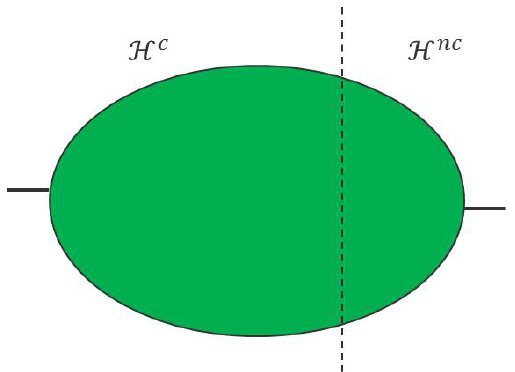
Figure 5: Illustration of the set of subrequirements H A = H c ∪ H nc for the main requirement A A H A . The a priori assumed initial state of H A could be given by the estimated probabilities P ( H A ) = p c and P ( ¬ H A ) = p nc . This 0 ,H A 0 ,H A is used for initiating the verification and ex- amination management